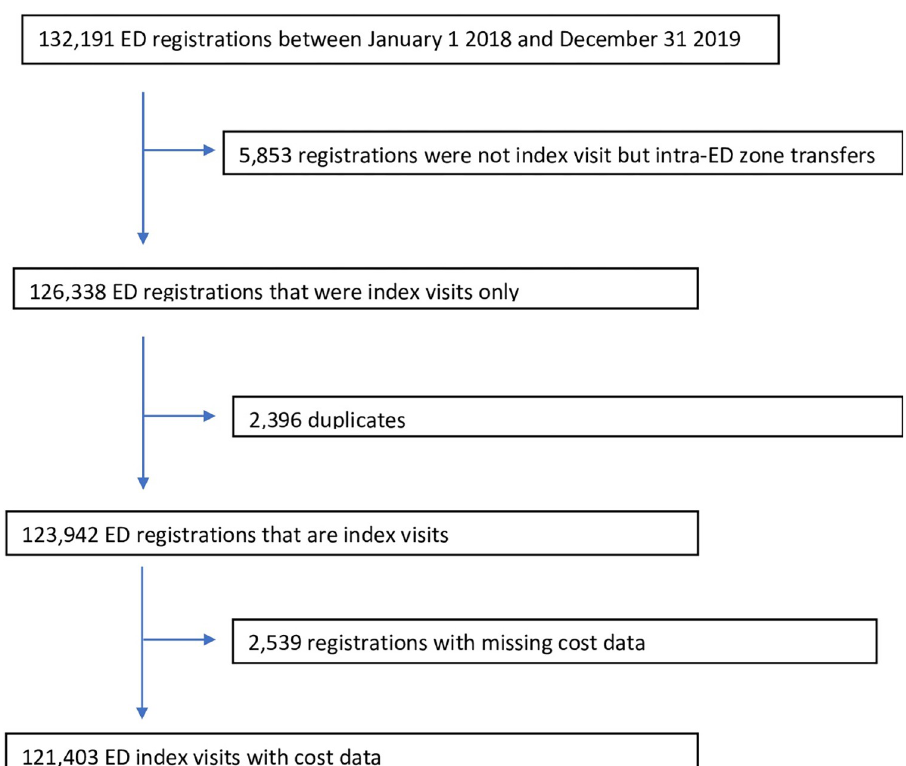
Fig 2. Flow diagram of O¨rebro ED registration